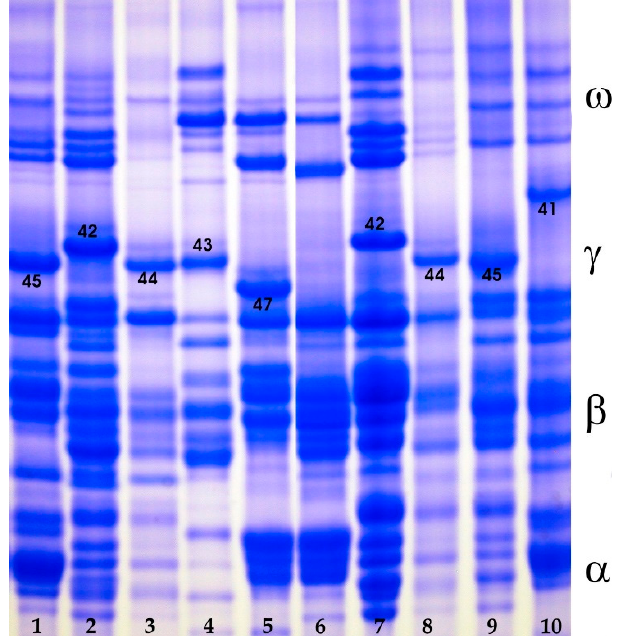
Figure 3. The γ -gliadin variants detected by acid polyacrylamide gel electrophoresis (A-PAGE) in the durum wheat landraces BGE002879 (1), BGE012334 (2), BGE013098(3), BGE018655 (4), BGE018311 (5), BGE019280 (6) and BGE019290 (10), and in the standard varieties ‘Jabato’ (7), ‘Alaga’ (8) and ‘Ardente’ (9).